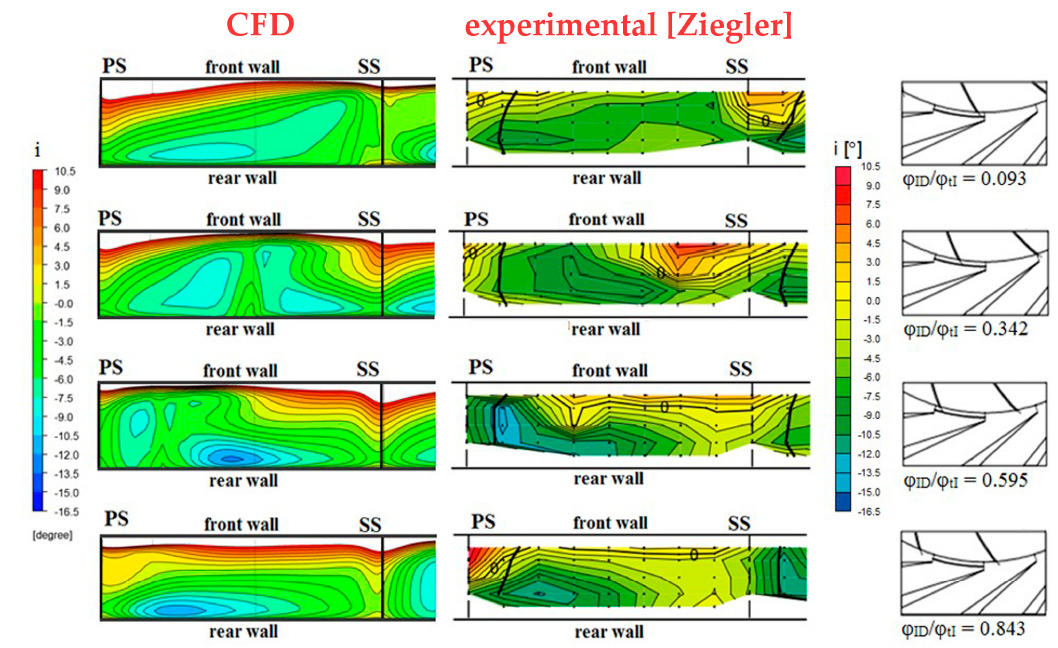
Figure 16. Unsteady incidence at 2M in the absolute frame of reference, point P1, comparison between numerical results of HR-KO (left) and experimental results (right).